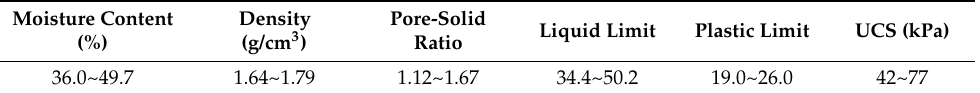
Table 1. Basic properties of silty clay in the 4 (cid:13) layer in Shanghai